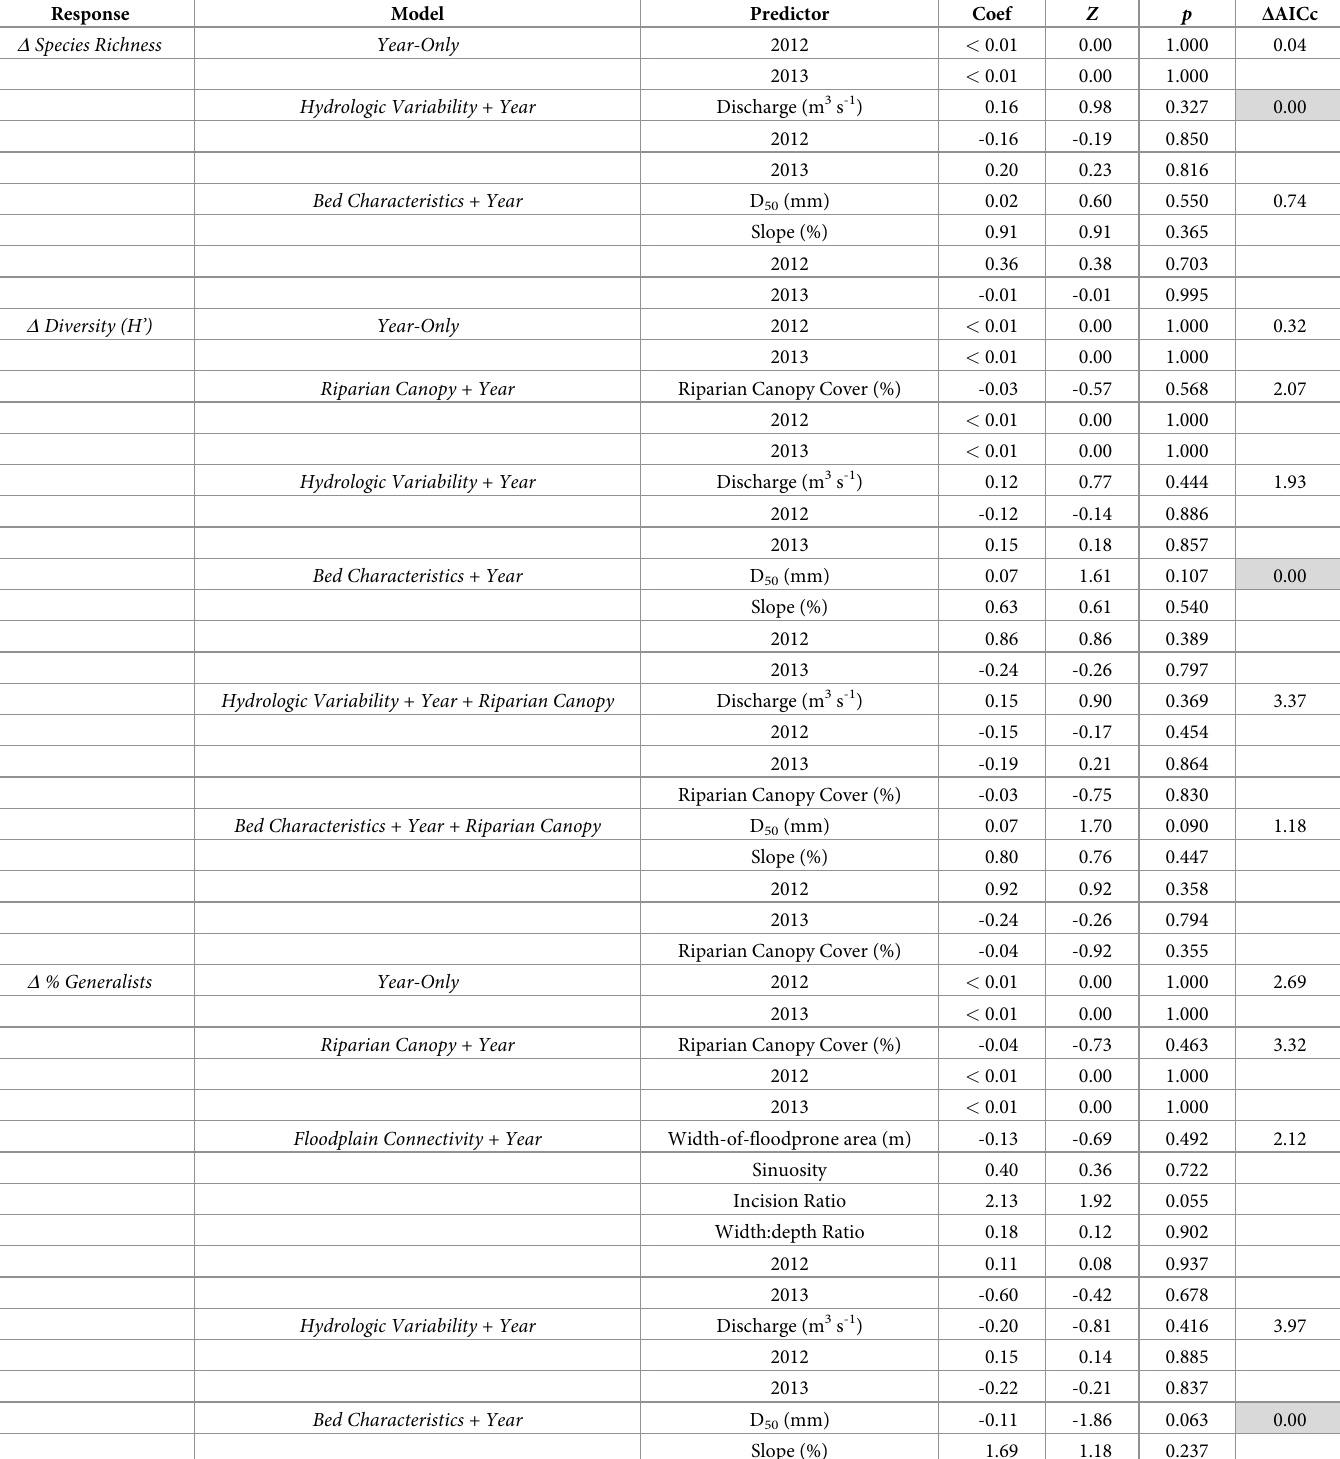
Table 4. Linear models for influences of hydrogeomorphic features on fish assemblage characteristics that showed moderate support ( Δ AICc � 4). Δ AICc = AICc (lowest)—AICc (model